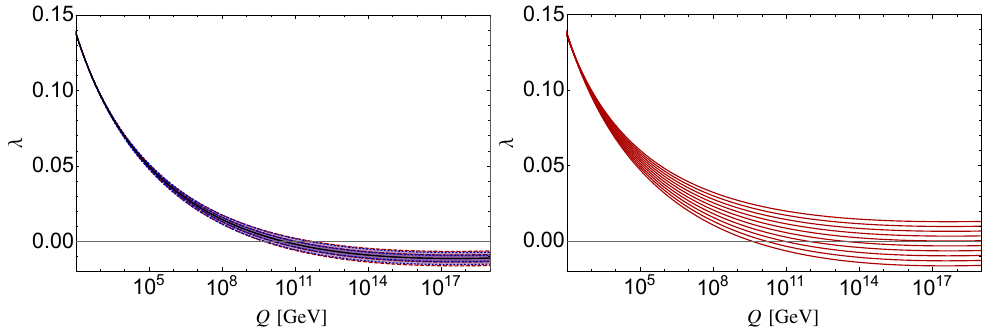
Figure 1. The Higgs quartic coupling λ as a function of the renormalization scale µ RG with different input standard-model couplings. In the left panel we show the running λ with the central values of the measured standard-model couplings including (2.21) (black solid line). The blue dotted (red dashed) lines indicate the 1 and 2 σ range by varying M t ( α s ) according to eq. (2.22) (eq. (2.21)). In the right panel, we show the scale dependence of λ with M t = 169 . 0 , 169 . 5 , 170 . 0 , · · · , 173 . 5 GeV from top to